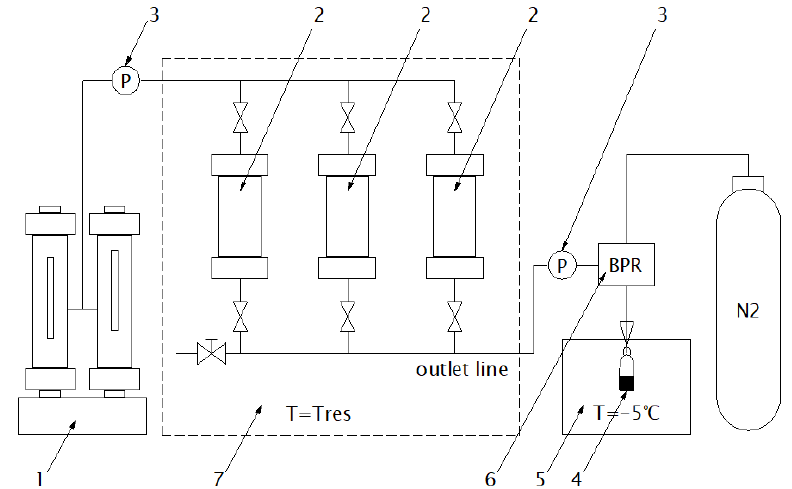
Figure 1. Scheme of equipment for tracer testing under reservoir conditions in water-organic phases. 1. High-pressure plunger pump; 2. Piston cylinder (3 pcs.) for tracer solution in oil/water phases; 3. Pressure sensors; 4. Vial for effluent collection; 5. Cryostat (thermostat); 6. Backpressure regulator;